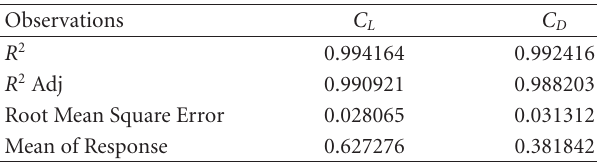
Table 2: Quality parameters of response surface of NACA 63-421